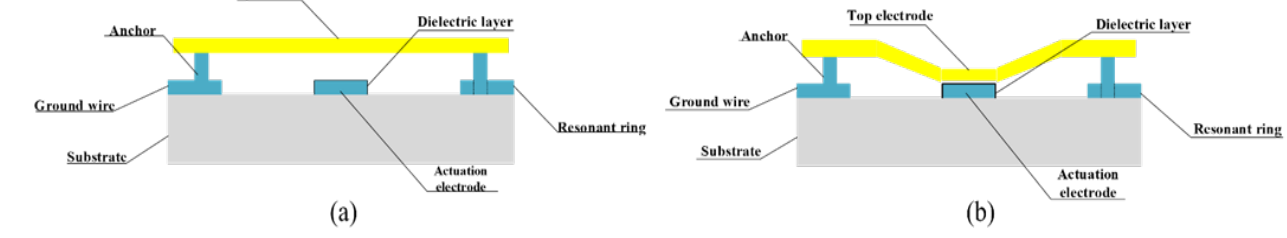
rings and ground lines to act as the resonant structure to be fixed on the CPW lines, and the anchor on the other side. In a double-ended fixed beam RF MEMS switch, the beam is fixed at both ends and is actuated using a voltage that is applied at both ends of the beam. When the maximal voltage (6.48 V) is applied, the displacement reaches its maximum value (1.5 μm). The operational states of the switch are shown in Figure 2.